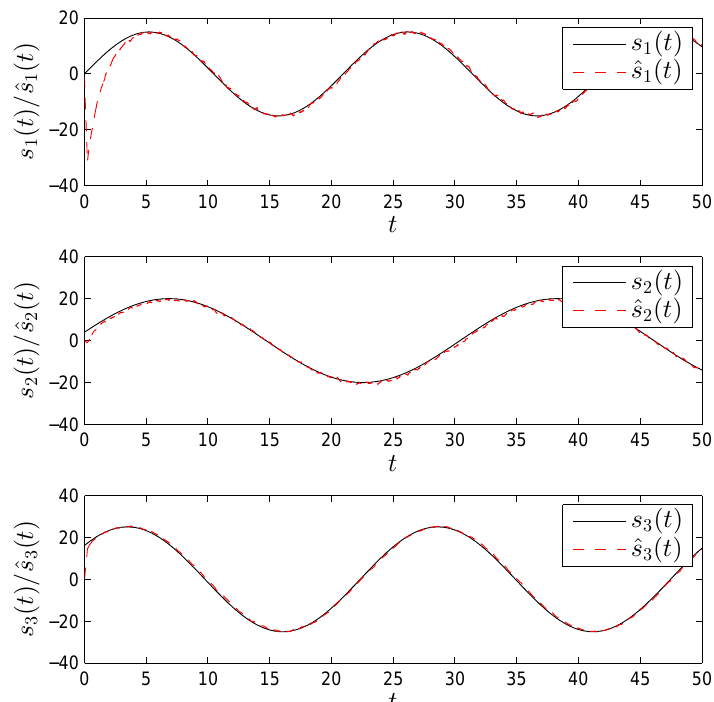
Figure 9. The recovered messages (cid:98) s i ( t ) from the n receive antennas after a 50–tap low–pass